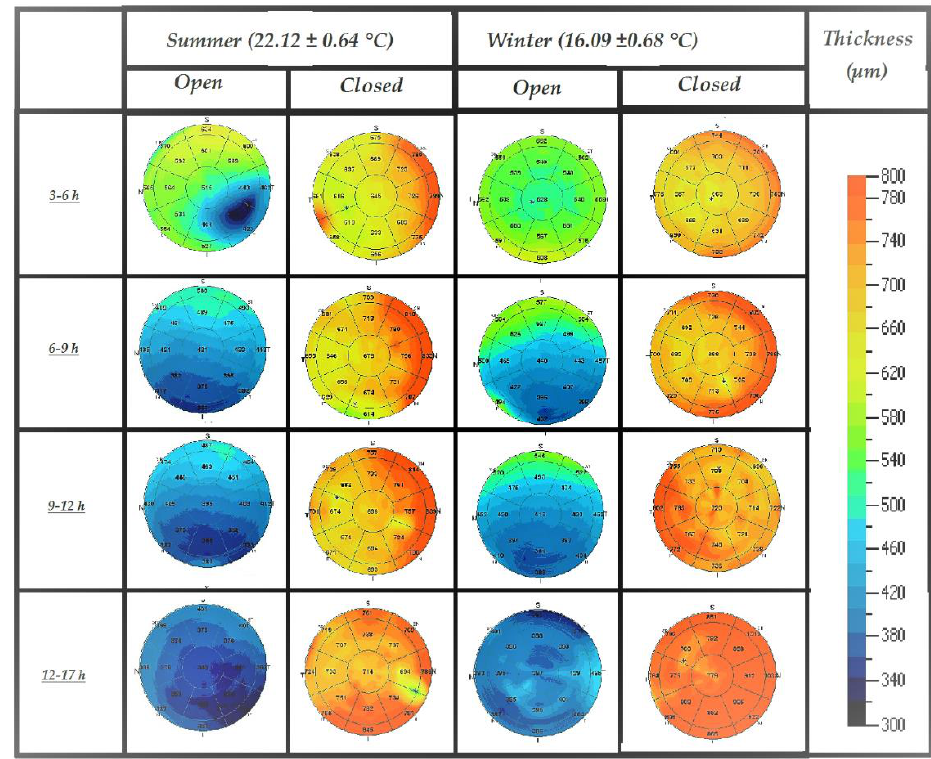
Figure 7. Pachymetric maps of central cornea (6 mm central area) at different postmortem intervals in closed and open eyes during the summer and the winter.